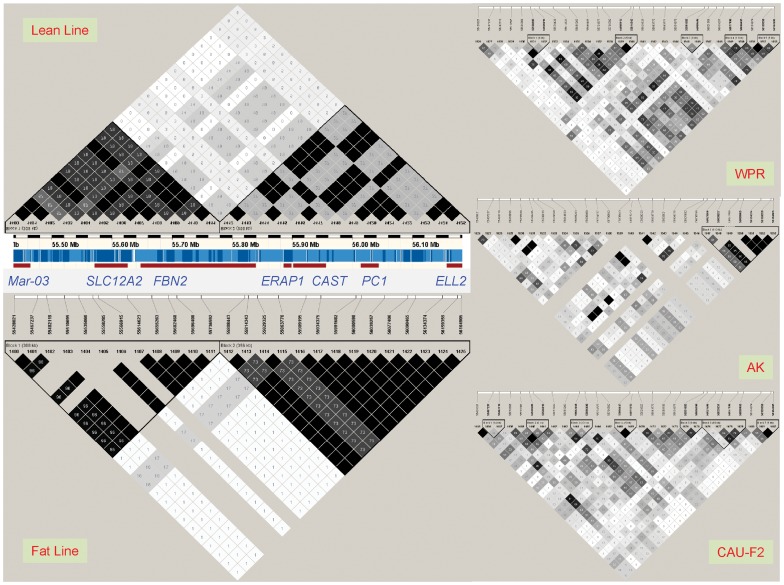
Linkage disequilibrium patterns of the chromosome Z selection signature at 55.43–56.16 Mb.WPR: a recessive white line of White Plymouth Rock chicken from France (n = 94). AK: Anak, a commercial broiler chicken introduced from Israel (n = 51). CAU-F2: an F2 resource population produced from reciprocal crosses of Silky Fowl and White Plymouth Rock at China Agricultural University (n = 112).